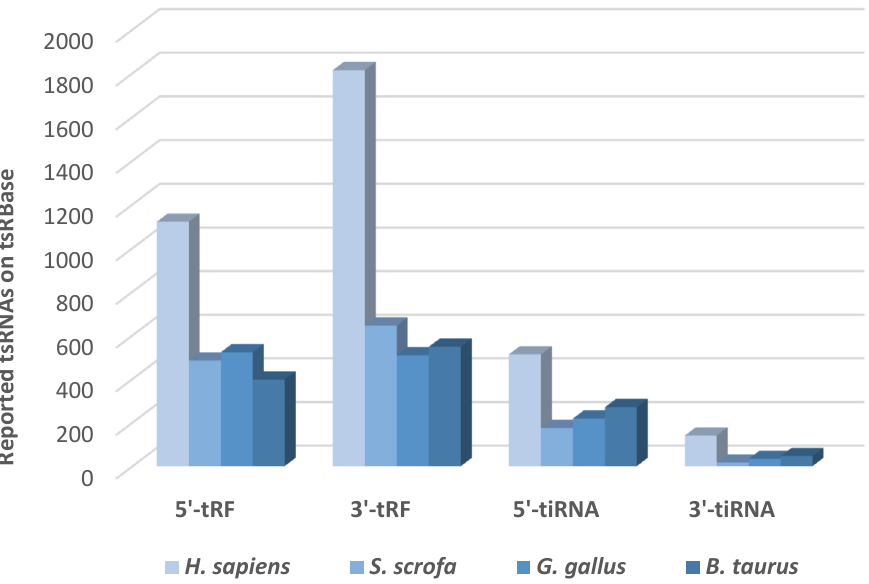
Figure 7. Reported tsRNAs in Homo sapiens , Sus scrofa , Gallus gallus , and Bos taurus on tsRBase.